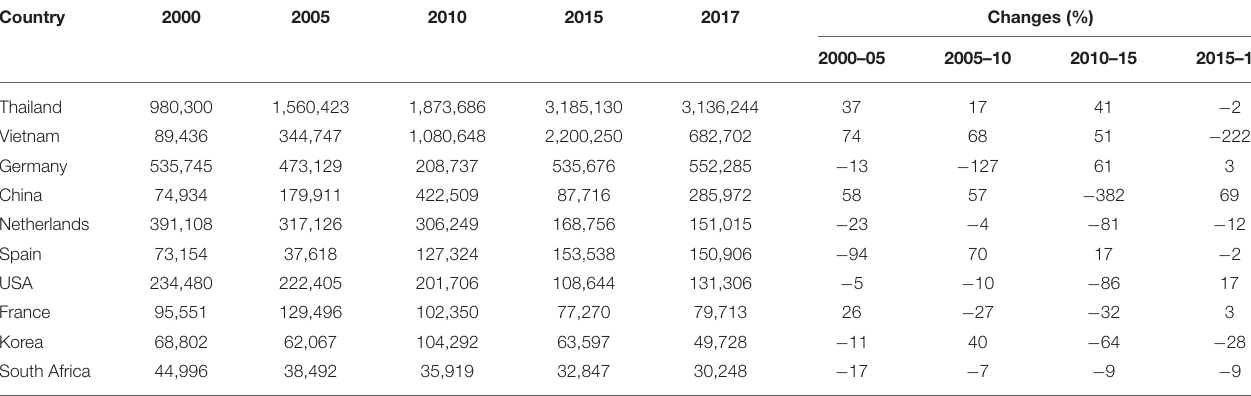
TABLE 2 | World top leading starch exporters (in ton). Country